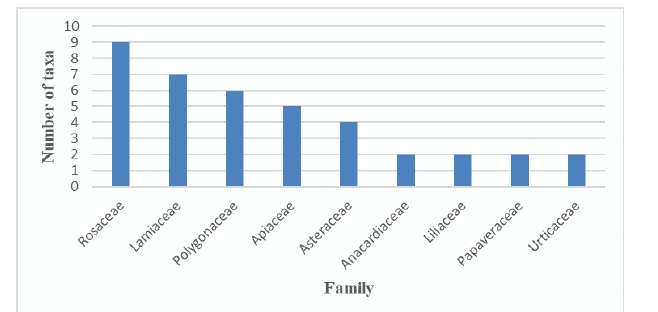
Figure 4 The most frequently used plant families.